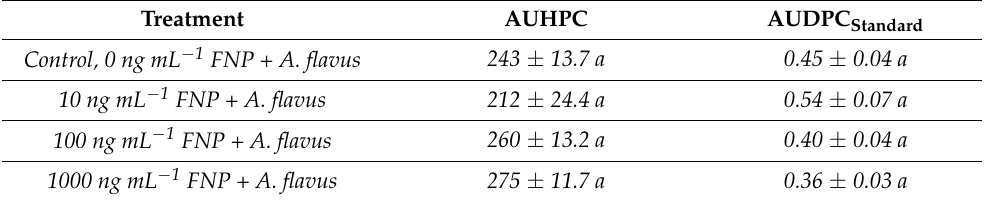
Values are represented as means ± SEM ( n = 3). The different letters indicate statistically significant differences between treatments at p < 0.05, using Tukey’s post-hoc